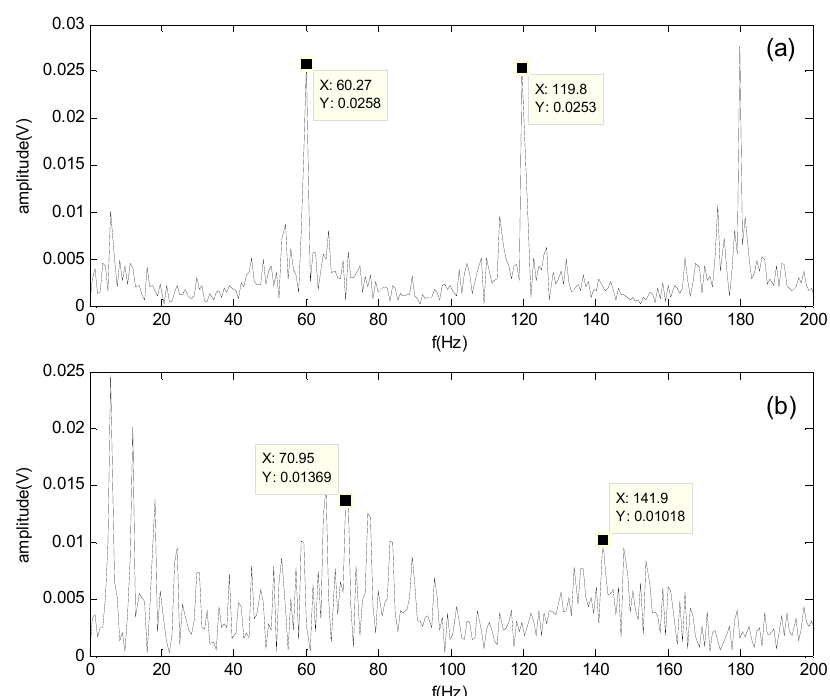
Figure 10. Spectrum of separated signals obtained by the proposed method at 900 rpm: ( a ) Spectrum of the outer-race defect; ( b ) Spectrum of the roller defect.